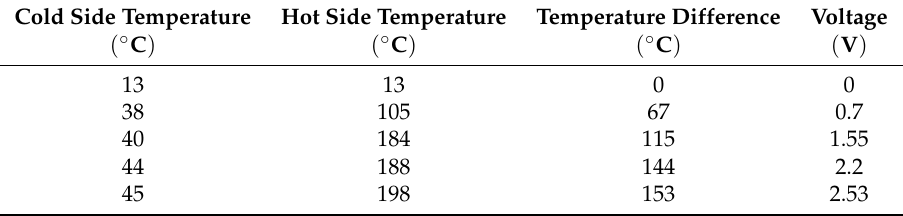
Table 2. Dependence of the voltage on temperature difference in Peltier cells for the second experimental measurement.